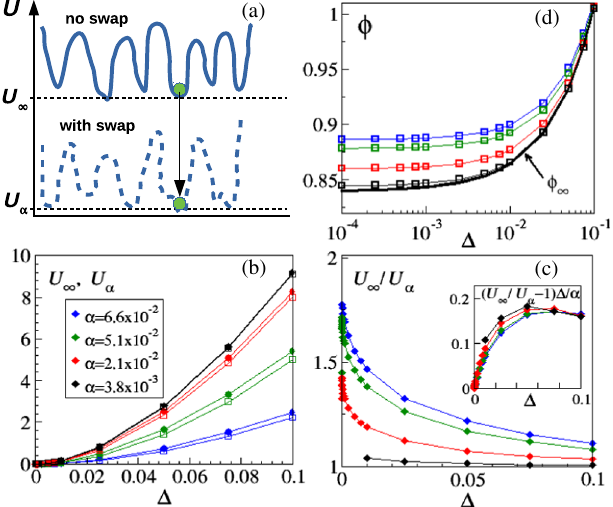
FIG. 5. (a) Illustration of the effect of SWAP on the energy landscape. Systems rapidly quenched with non- SWAP dynamics display an energy U ∞ . These states are unstable to a steepest descent with SWAP , leading to a lower energy U α : metastable states appear at lower energies with SWAP . (b) Values for U ∞ (full symbols) and U α (open symbols) as a function of the dimension- less pressure Δ imposed during the quenches as a function of ¯ α as shownin thelegend.Theratio U ∞ =U α isshown in(c), it isstronger near jamming but the effect remains significant important even far for jamming if the system is sufficiently polydisperse. As shown in the inset, in relative terms the shift of the energy of inherent structures ð U ∞ − U α Þ =U α is proportional to α and inversely proportional to Δ when Δ is large enough. (d) The packing fraction ϕ obtained after SWAP is turned on is larger than ϕ ∞ c obtained for non- SWAP dynamics, an effect that is stronger near